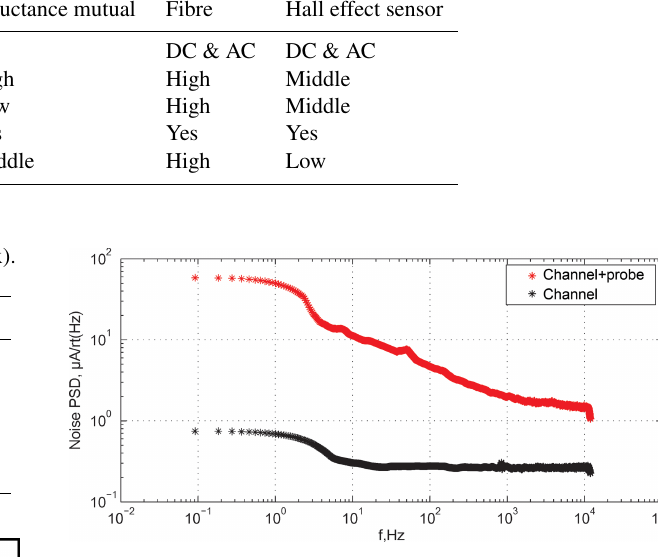
Figure 6. Current noise power spectrum density of the current probe and data acquisition unit obtained on a magnetic shield barrel.